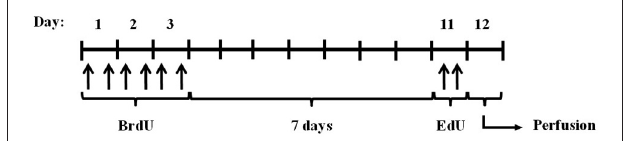
FIGURE 1 | Experimental procedure . Cast + / + and Cast − / − mice were treated with BrdU for 3 days (every 12 h), and after 7 days with EdU (twice, 2 h apart). The animals were then sacrificed by transcardial perfusion, on day